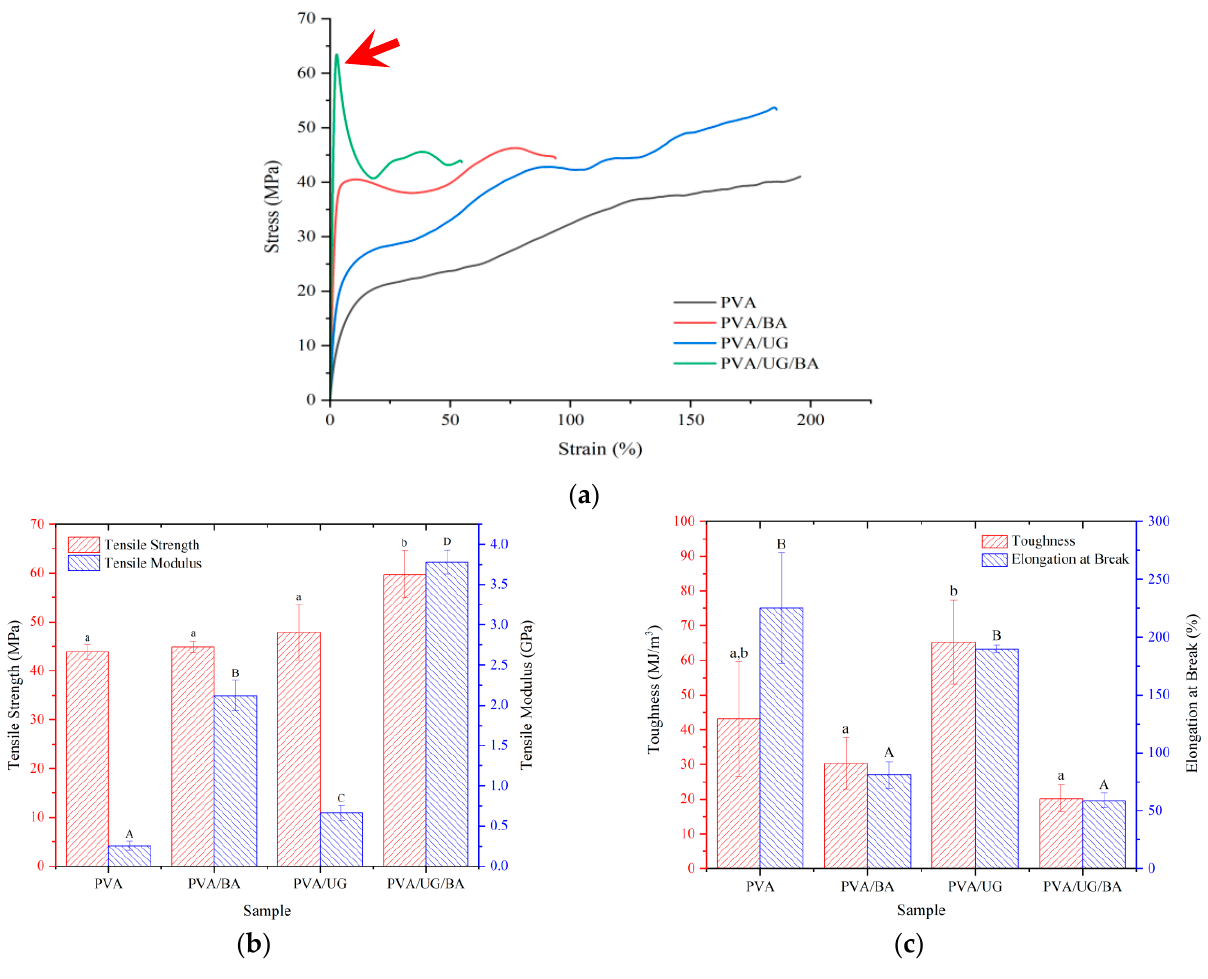
Figure 6. Stress–strain curve of samples ( a ), the average value of TS and TM ( b ), and TN and EB ( c ) for samples. A significant difference in mean values ( p ≤ 0.05) is indicated with different letters (a, b, A, B, C, D).